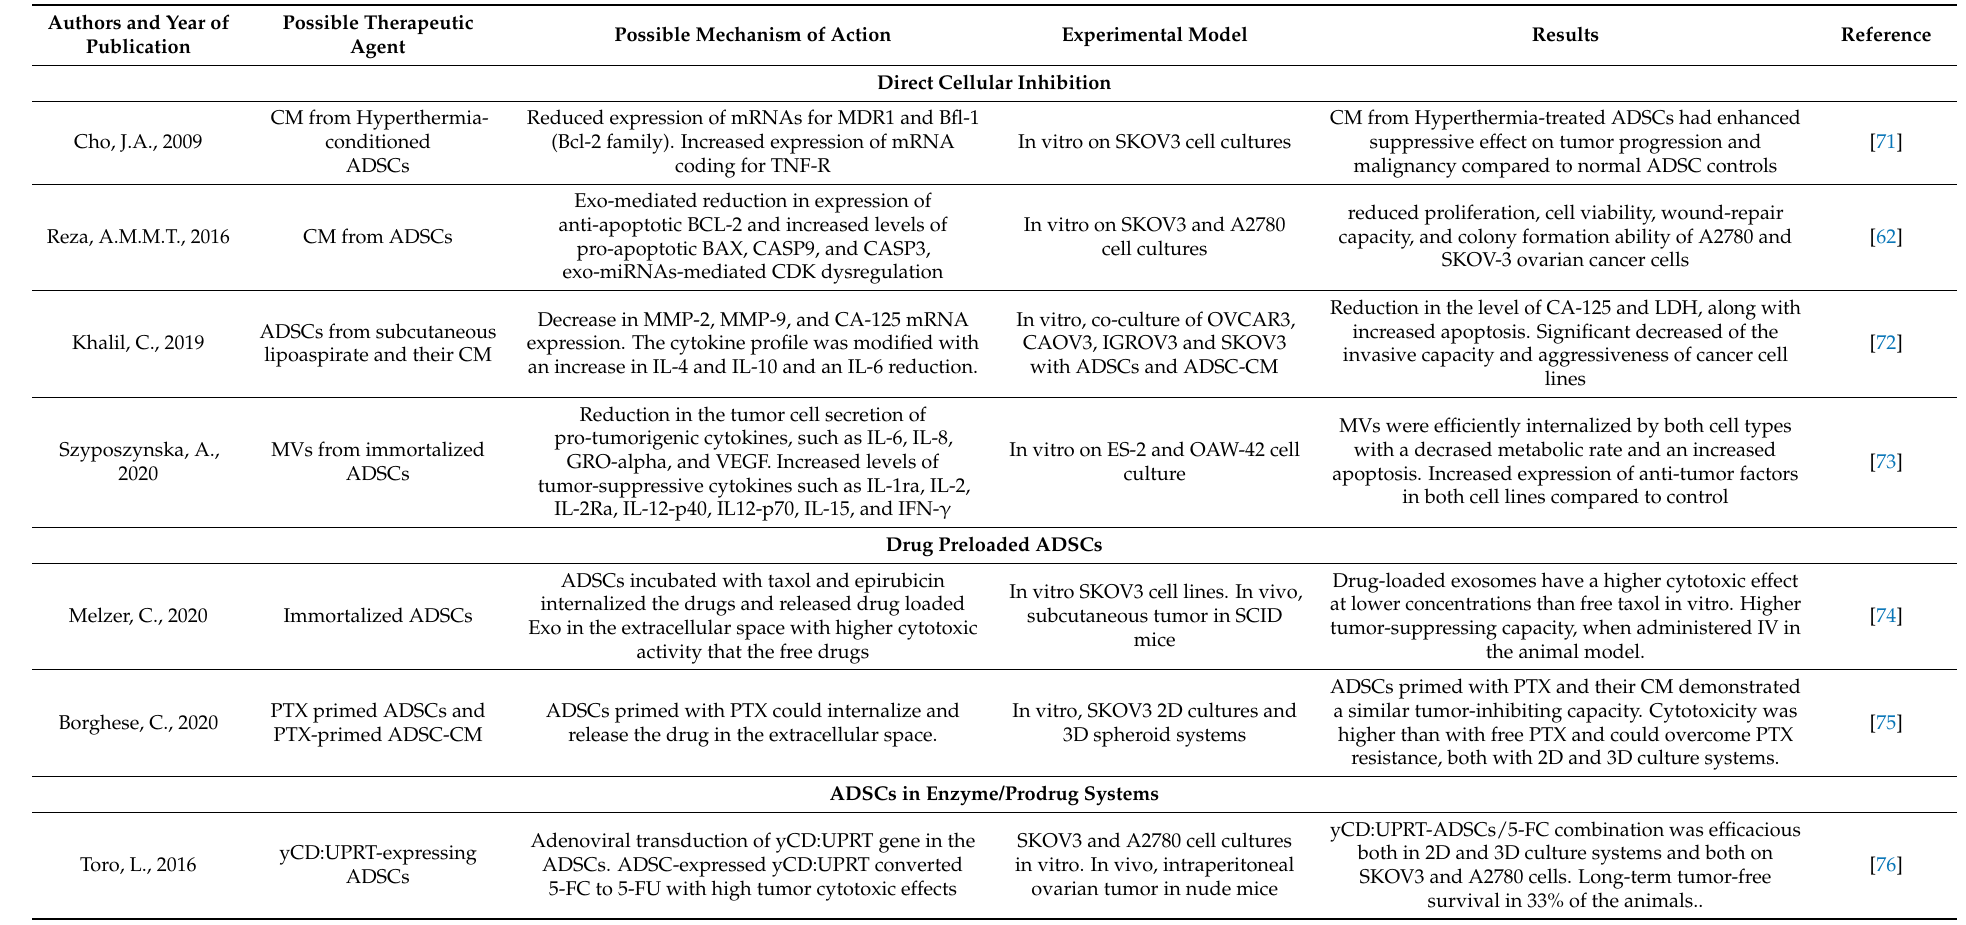
Table 1. Possible ADSC-based therapeutic strategies for ovarian cancer Abbreviations: ADSC: adipose-derived stem cells; CM: conditioned medium; Exo: exosomes; MV: microvesicles; PTX: Paclitaxel; IRI: